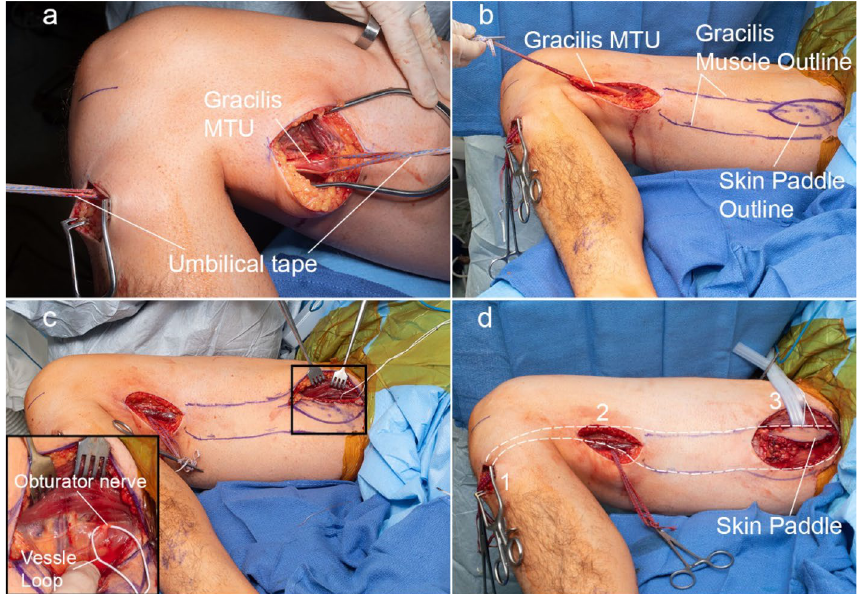
Figure 8. Surgical procedure for preparing the gracilis MTU for testing. ( a ) The gracilis tendon is freed from surrounding soft tissue between the tibia incision and distal medial thigh incision. Umbilical tape is place around the gracilis MTU at incision 1 and incision 2. Soft tissue attachments to the tendon are dissected until the tendon glides freely when either tether is pulled. ( b ) The outline of the gracilis and skin paddle is drawn on the medial aspect of the thigh. ( c ) The obturator motor branch is located and identified using a vessel loop. ( d ) The gracilis MTU ready for intraoperative testing after the proximal paddle incision is made and proximal gracilis tendon identified. (1) Tibia incision, (2) distal medial thigh incision, (3) proximal medial thigh